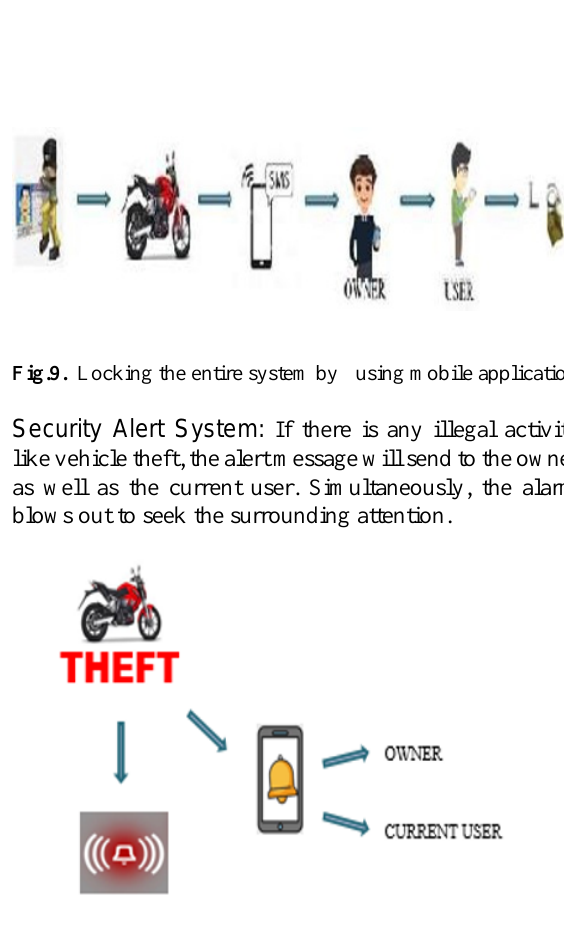
Fig.10 . Emergency alert to have higher security